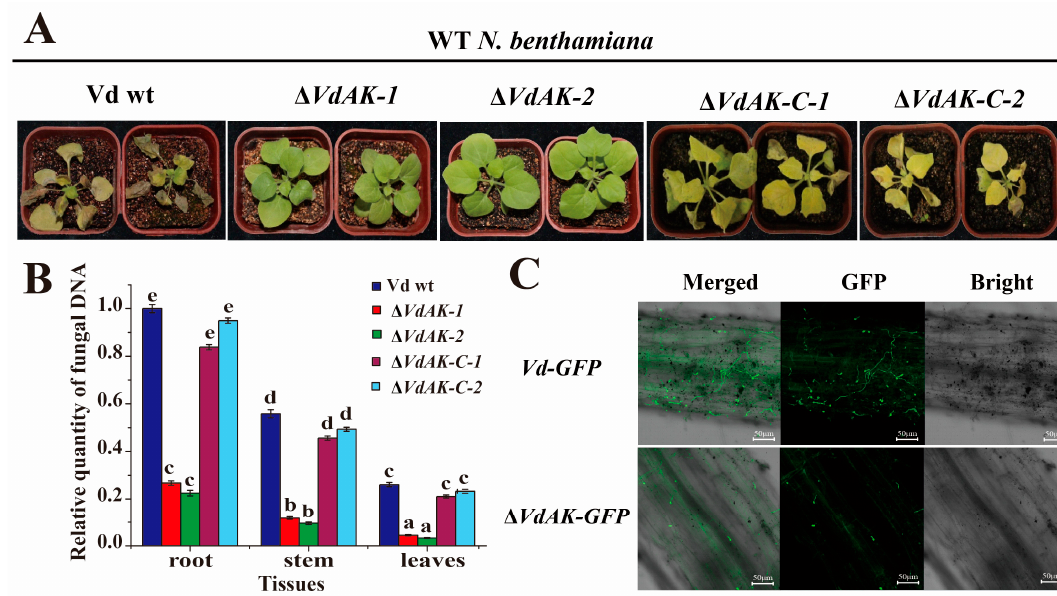
Figure 3. Virulence analysis of disruption ( Δ VdAK ), complementation ( Δ VdAK-C ), and wild-type Vd strains in N. benthamiana . ( A ) Symptoms on seedlings 12 days after roots were dipped in 10 6 spores/mL of Δ VdAK , Δ VdAK-C, or wild-type Vd (Vd wt). ( B ) Relative amounts of fungal DNA as determined by RT-qPCR. Means (± SE) from three independent experiments were analyzed for significant differences among treatments using Duncan’s test ( p <0.05), as indicated by different letters. ( C ) Micrographs of fluorescing hyphae in N. benthamiana root tips at 5 dpi with Vd-GFP or Δ VdAK-GFP .